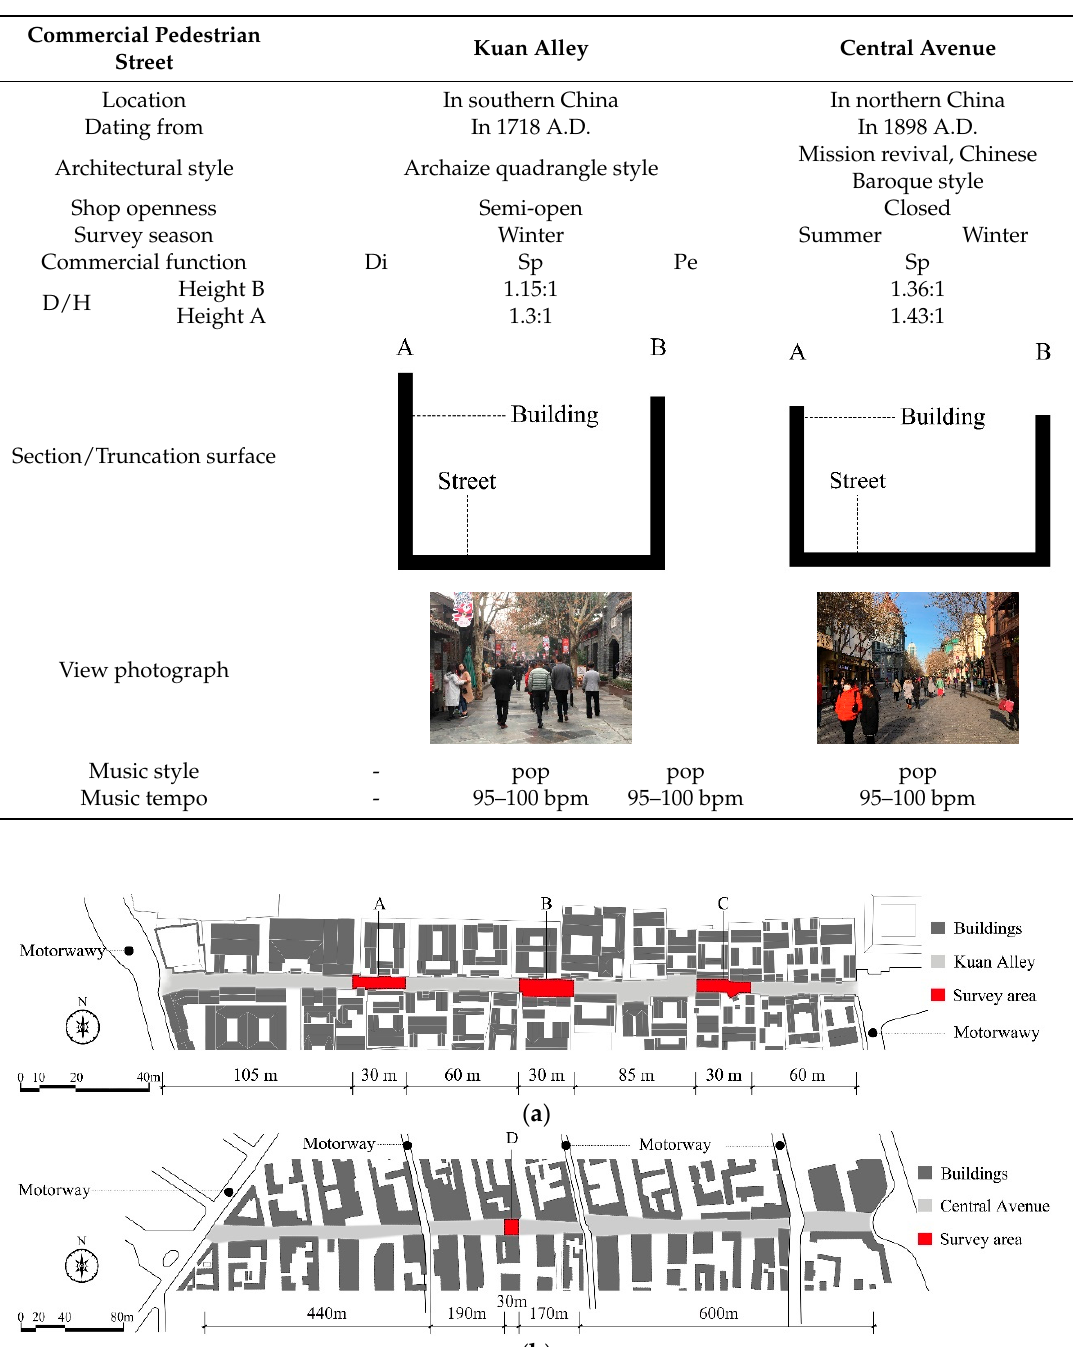
Figure 1. The survey areas of commercial pedestrian streets: ( a ) Kuan Alley; ( b ) Central Avenue, and A refers to the Di zone, B and D refer to the Sp zone, C refers to the Pe zone.